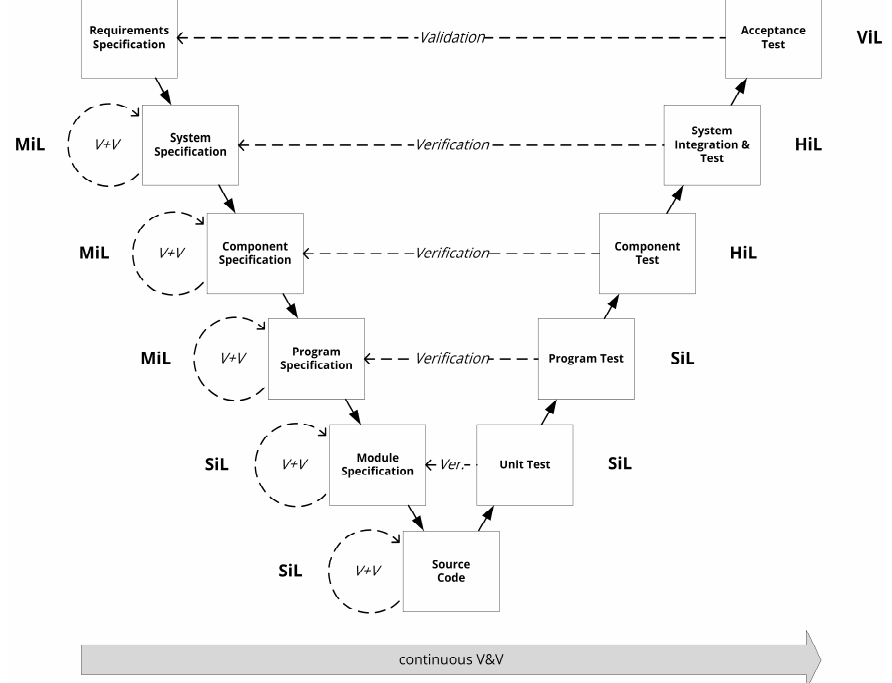
Figure 5. Classical V-model adapted to the development of vehicular assistance systems and simu- lative continuous V&V with frontloading based on the processes proposed in [20,21]. The process shown is complemented by the corresponding type of SuT integration for each step of the simulation- based continuous V&V (cf. Table